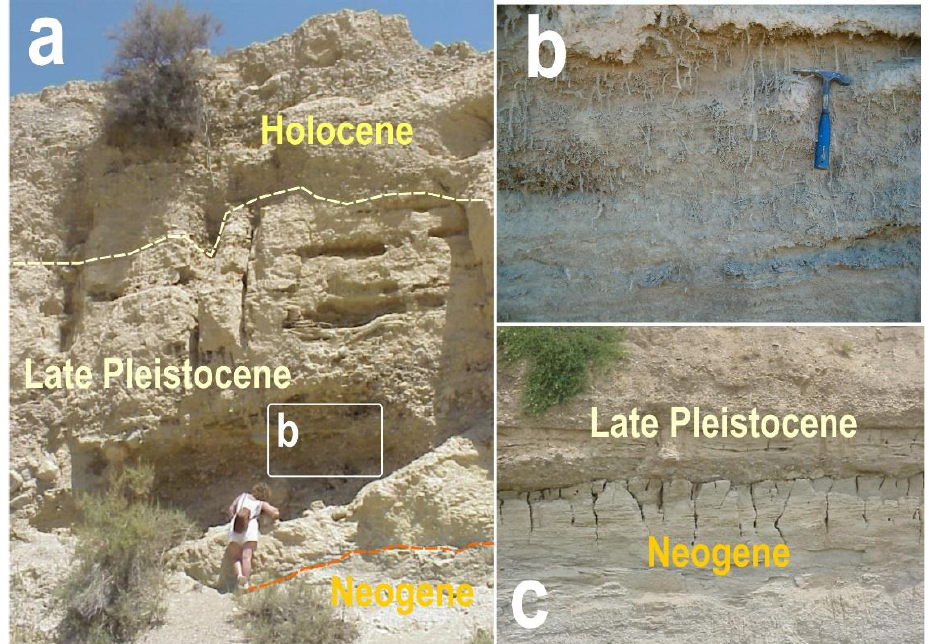
Figure 4. Relationships among Late Pleistocene, Holocene deposits and the Neogene substratum at Puente Nuevo section (see location in Figure 1). ( a ) Assemblage of Late Pleistocene conglomerates and sands over the Neogene sediments. Scale Teresa Bardají 1.55 m. ( b ) Travertine levels in the Late Pleistocene deposits outcropping close to the base of Late Pleistocene deposits in the zone. Scale Estwing hammer 35 cm. ( c ) Details of the unconformity between the Neogene substratum and Late Pleistocene sediments near Librilla downstream the Puente Nuevo section. Note the impressive size of desiccation cracks 0.6 – 0.9 m deep.